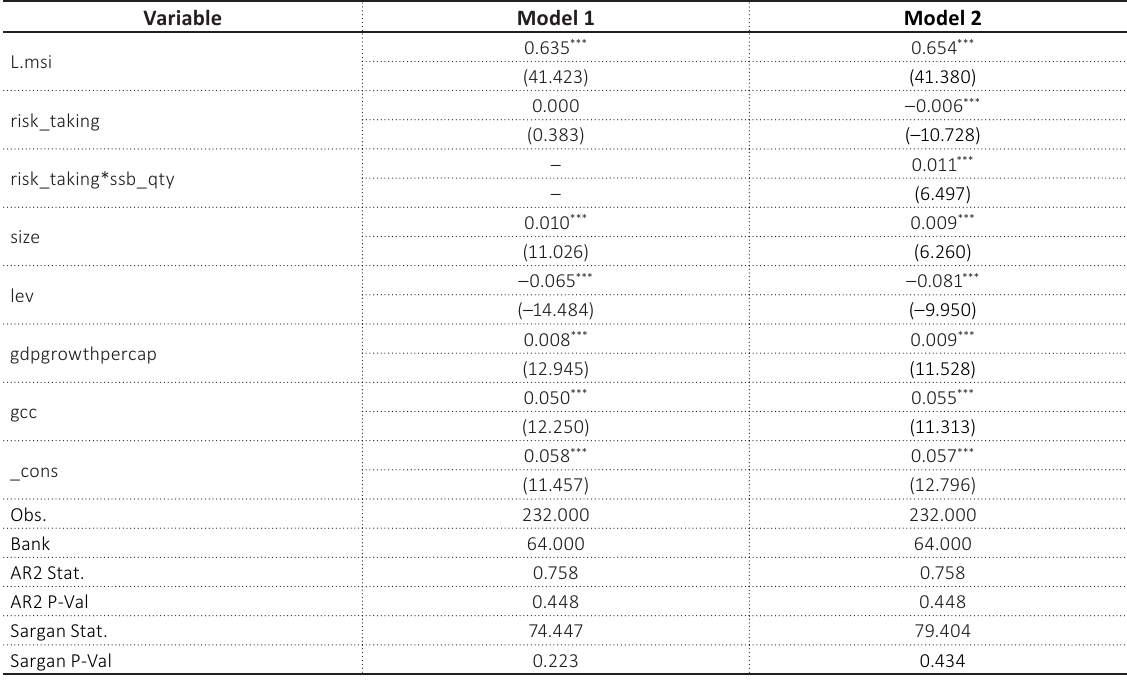
Table 6. Baseline full sample (2-step system